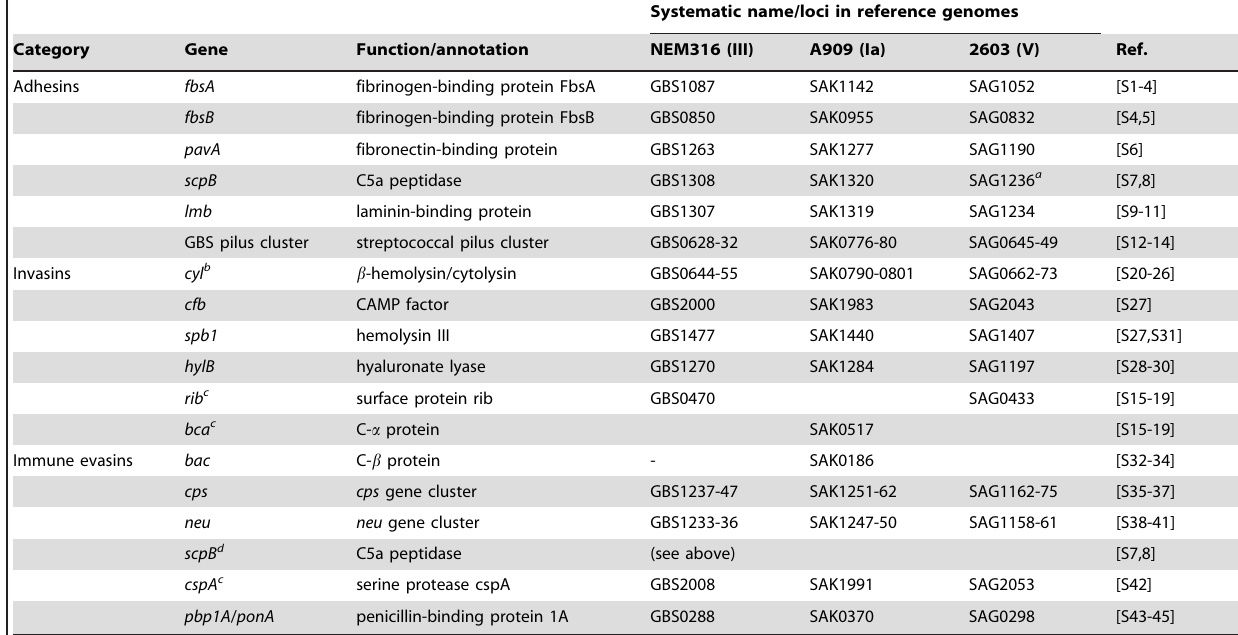
Systematic name/loci in reference